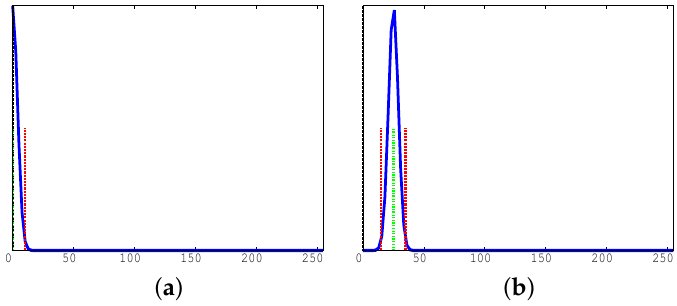
Figure 6. Difference histograms for: ( a ) a cell with no notable background alteration, ( b ) a cell with a rapid luminosity transition. In the second case there are no Gaussian points in the origin. Vertical lines represent average (green) and variance (red) on all bins.